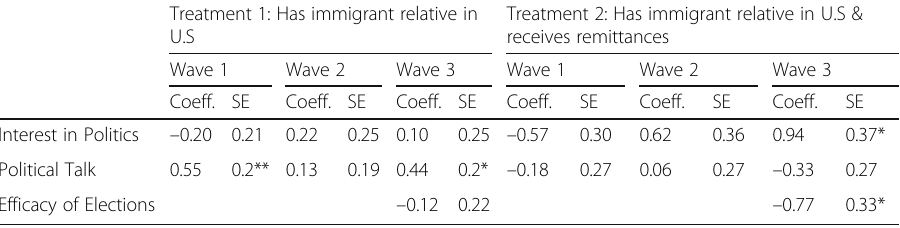
Table 3 Migration effect of immigrant relatives and remittances on political interest, talk, and efficacy of Mexican